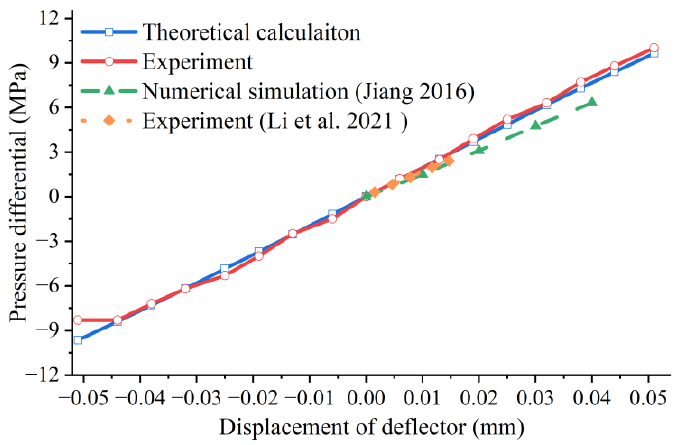
Figure 19. Comparison of pressure differential [31,32].